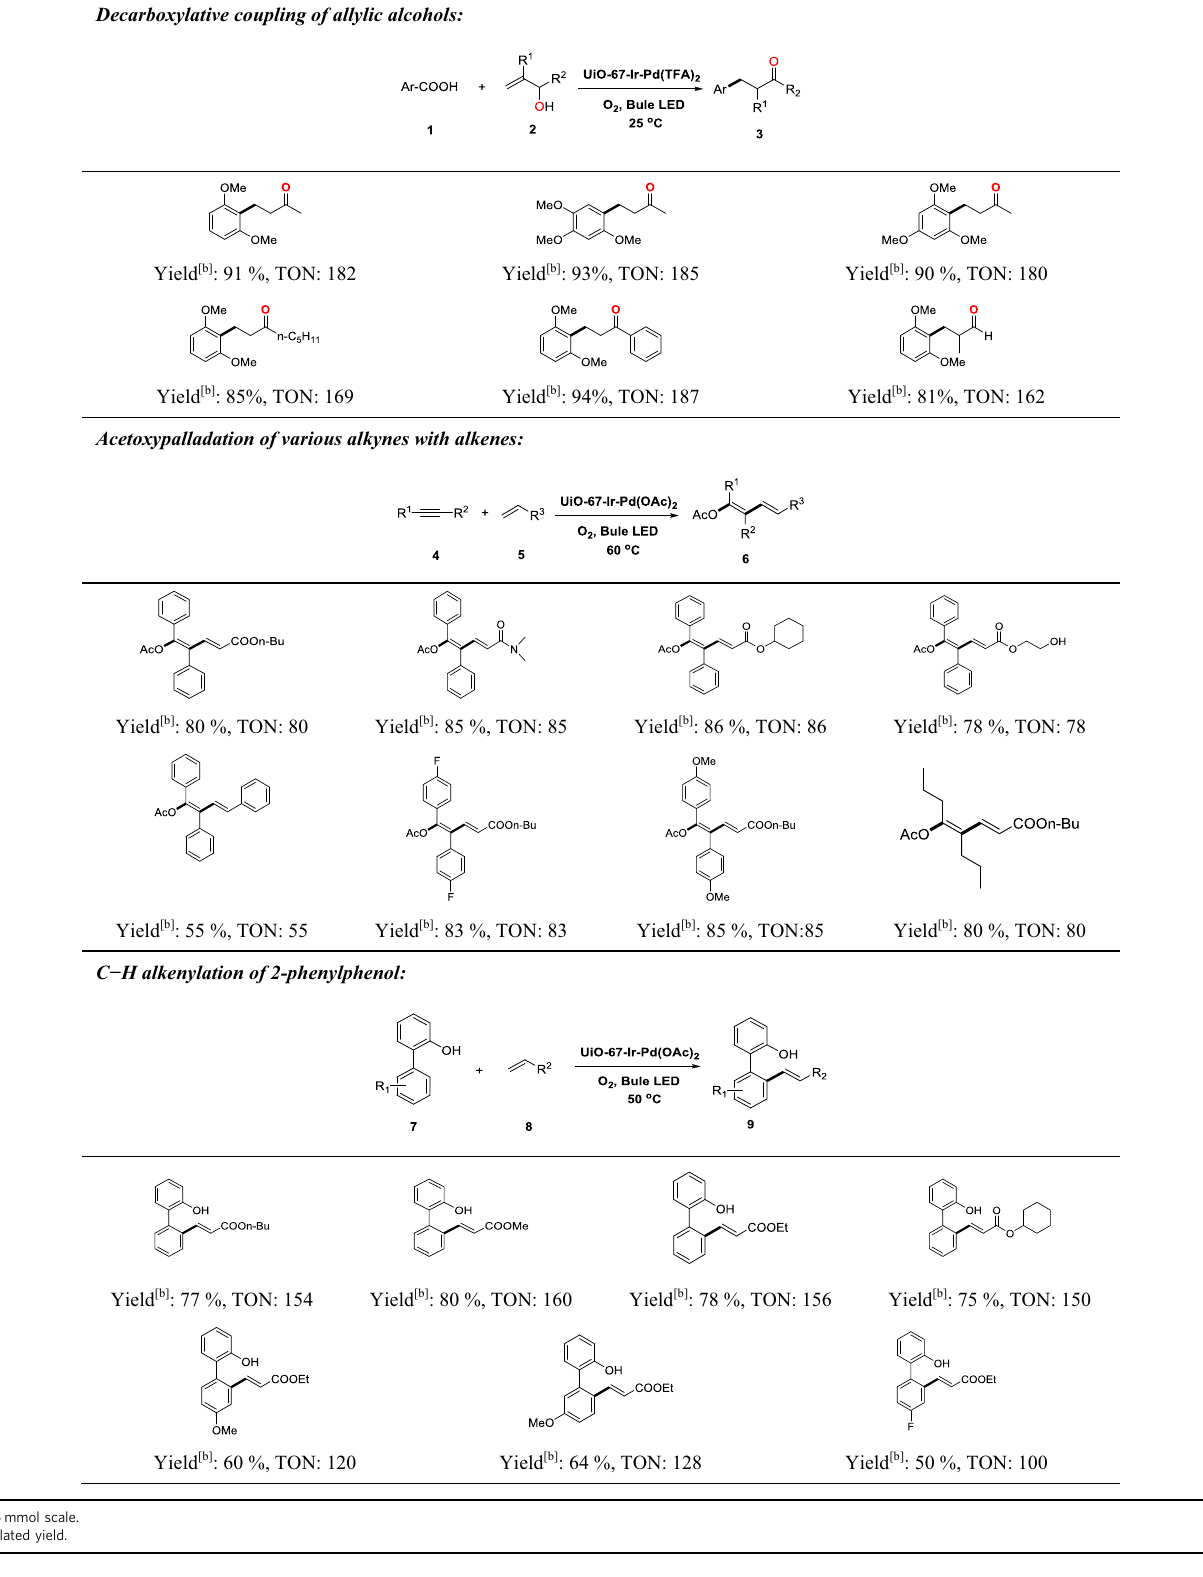
Decarboxylative coupling of allylic